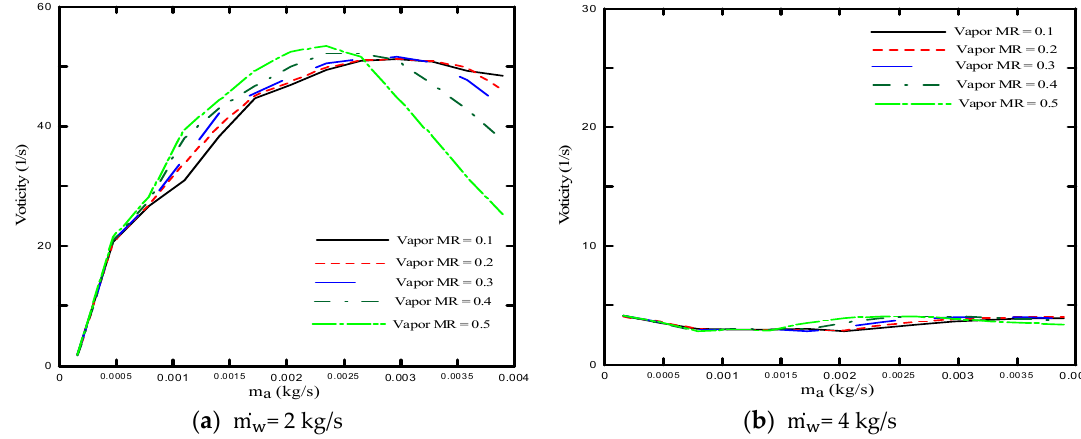
Figure 9. Effect of air and vapor mass flow rates on the turbulent kinetic energy in the tube upper region.